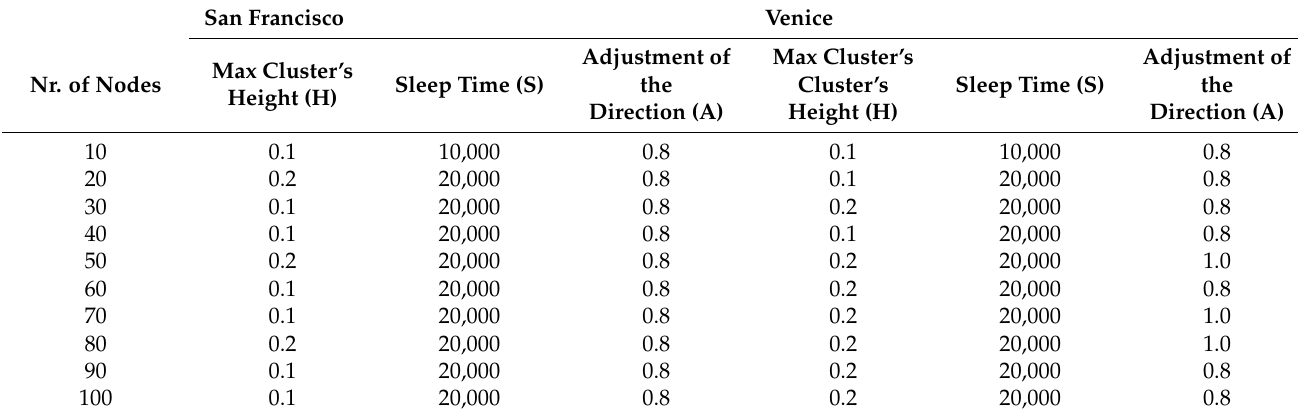
Table 6. The used settings of H, S, and A in Blossom for the simulations.